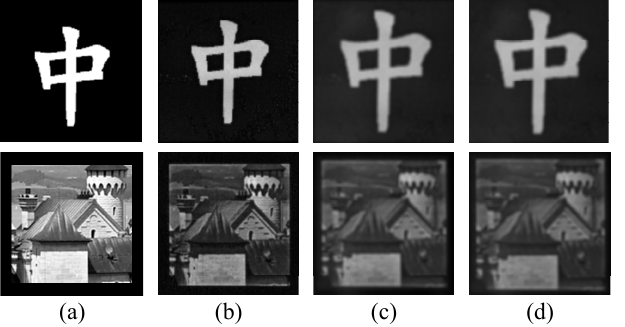
Figure 8. ( a ) is the original object image, ( b – d ) are respectively captured by the CMOS camera in the environment without water, with water, and with water and turbulence. ( b – d ) are cropped from the camera image and not scaled to ( a ).